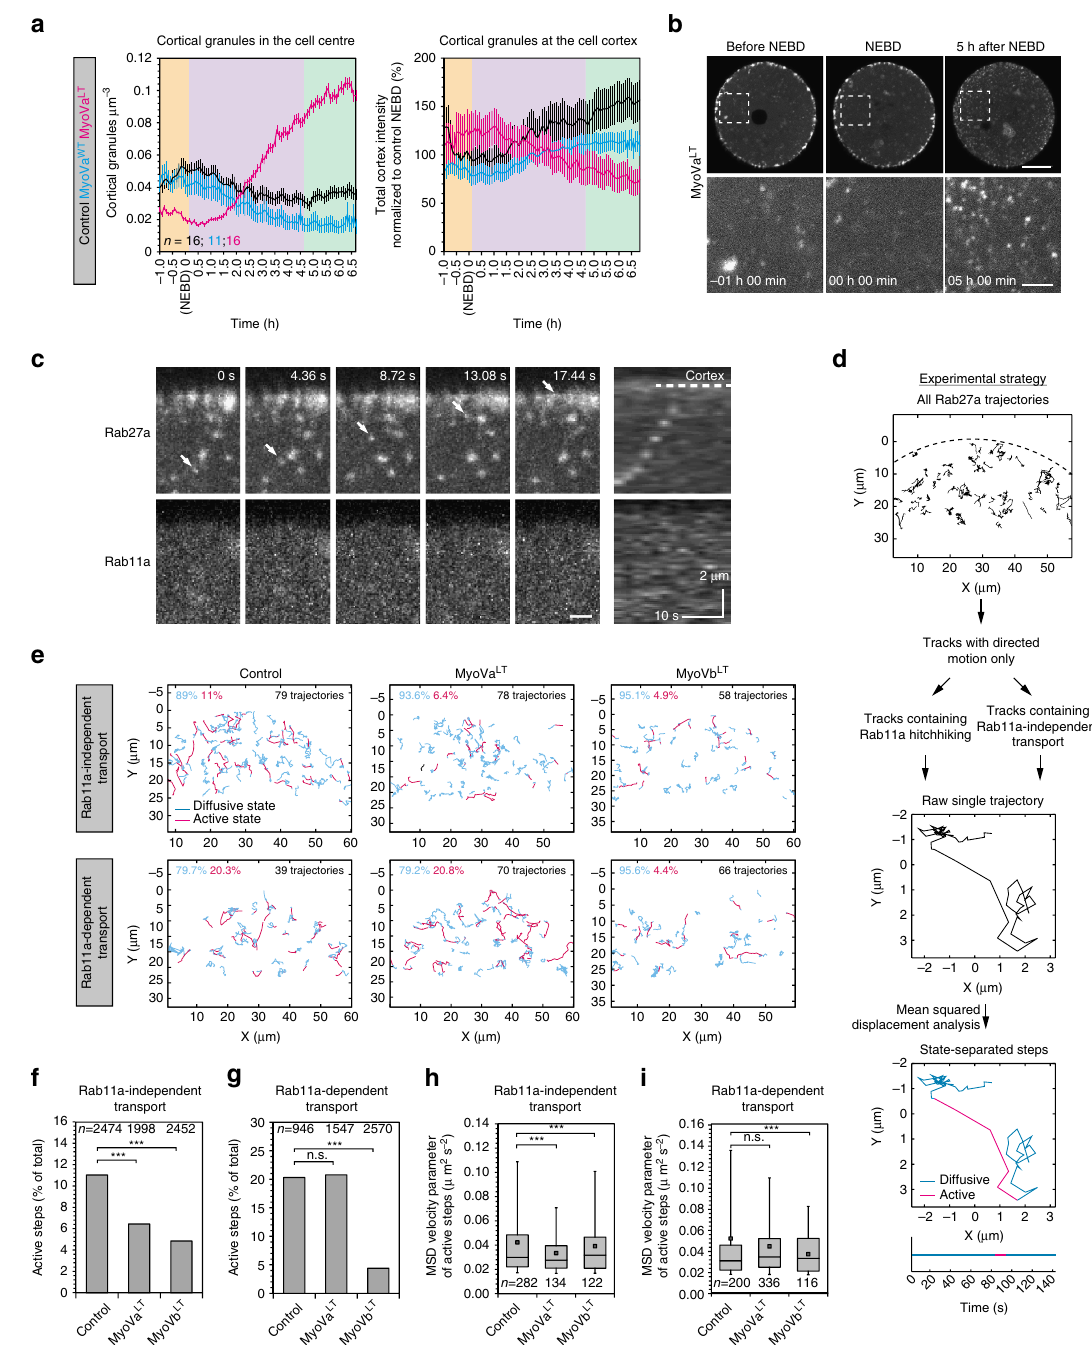
Figure 5 | A myosin Va-dependent pathway powers cortical granule translocation. Quantification of cortical granule translocation in the oocyte centre or cortex (mean ± s.e.m) in cells expressing either wild-type myosin Va (MyoVa WT ), a dominant-negative mutant (MyoVa LT ), or control ( a ), with representative example still images (maximum intensity projections of confocal Z sections) in b . Still images from MyoVa WT -expressing cells are included in Supplementary Fig. 2. Scale bars, 20 m m (overview) and 5 m m (enlarged). ( c ) Example still images of a cortical granule (Rab27a) translocating to the cortex in a Rab11a-independent manner (indicated by arrows), with corresponding kymograph. Scale bar, 2 m m. ( d ) Schematic diagram of the local mean squared displacement analysis of Rab27a trajectories that contained Rab11a-dependent transport (hitchhiking) or Rab11a-independent transport, and excluding purely diffusive trajectories. Each track was analysed by MSD with a short lag time to distinguish between active (magenta) and diffusive (blue) states on a step-by-step basis. ( e ) Combined Rab27a trajectories that contained Rab11a-dependent transport (hitchhiking) or Rab11a-independent transport in oocytes expressing MyoVa LT , MyoVb LT , or control, after local MSD analysis. Active states are coloured in magenta, while diffusive states are in blue. Proportion of each state is indicated (%). ( f – g ) Total number of active steps from Rab27a trajectories (as determined by MSD analysis; % of total steps) containing either Rab11a-independent transport ( f ), or Rab11a-dependent transport (hitchhiking; g ) in oocytes expressing MyoVa LT , MyoVb LT , or control. Total number of steps in each category is indicated. Compared using Fischer’s exact test. ( h – i ) Mean squared displacement velocity parameters of the active steps from Rab27a trajectories containing Rab11a-independent ( h ) or Rab11a-dependent transport ( i ) in oocytes expressing MyoVa LT , MyoVb LT , or control. Number of active steps in each category is indicated. Tukey box plots in h and i show the median (line), mean (small square), interquartile range, and the 5th and 95th (whiskers), compared using Mann-Whitney’s U test. Significance levels: ns, non-significant, *** P o 0.001, from three experiments. NATURE COMMUNICATIONS|7:13726|DOI: